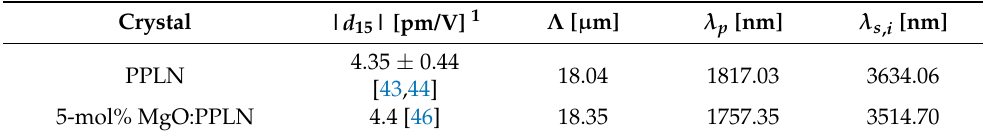
Figure 3. Numerical simulation results of Type II extended phase matching (EPM) in ( a ) a PPLN and ( b ) a 5-mol% MgO:LN. The poling period ( Λ ) satisfying the first-order quasi phase matching (QPM) and the temporal walk-off per unit crystal length ( Δ T / L ) are plotted as a function of λ p . Table 1. Type II EPM properties of two kinds of PPLNs: the poling periods ( Λ ), the resonant pump wavelength ( λ p ), and the corresponding signal/idler